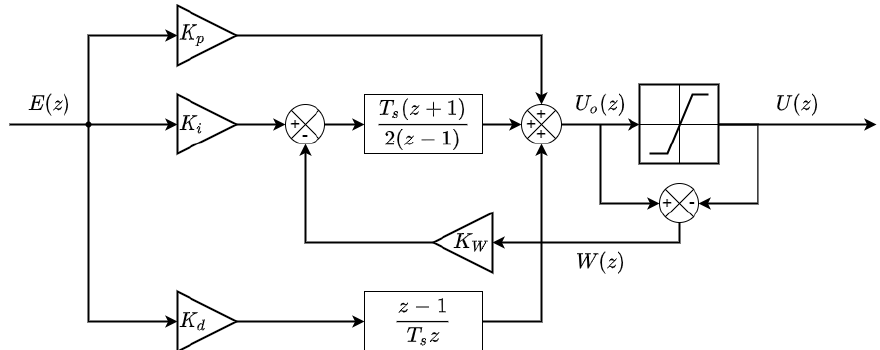
Figure 4. PID block diagram.